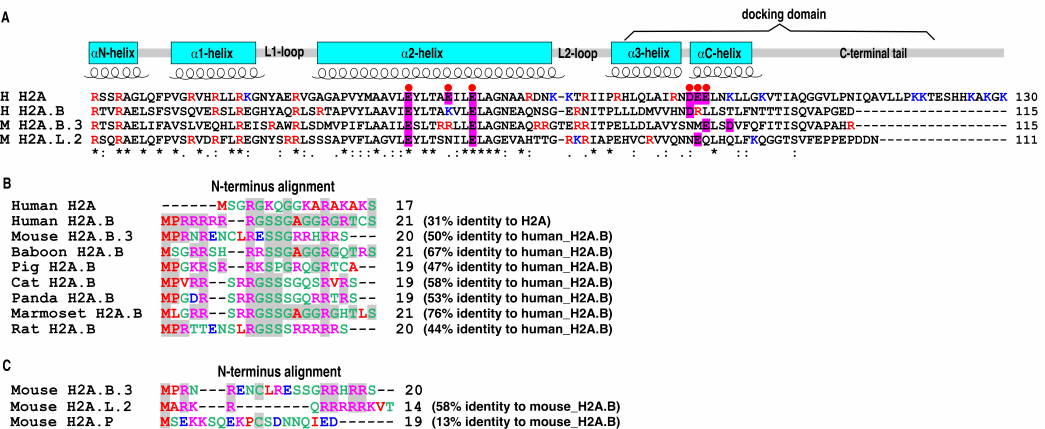
Figure 1. ( A ) Multiple protein sequence alignments of human H2A and H2A.B, and mouse H2A.B.3 and H2A.L.2. The structural features of the histone fold are annotated above the alignments. Arginine and lysine residues are highlighted in red and blue, respectively. The residues composing the “acidic patch” are shaded in magenta, and the “acidic patch” residues of H2A are annotated with red dot on top. The similarity of amino acid residues is indicated by the following symbols below the alignment: “*” (identical residues), “:” (residues with strongly similar properties) and “.” (residues with weakly similar properties). ( B ) Multiple amino acid residue alignments of the H2A.B N-termini of di ff erent eutherian mammals. Residues identical to those of human H2A.B are shaded in grey. ( C ) Alignments of the N-termini of all the short histone H2A variants expressed in the mouse. The residues identical to those of H2A.B.3 are shaded in grey. The amino acid residues are coloured following the default colour scheme of Clustal Omega (acidic residue, blue; basic residue, magenta; hydrophobic residue, red; polar residue, green). All multiple sequence alignments are generated using the EBI web server Clustal Omega (version 1.2.4) (EMBL-EBI, Hinxton, Cambridge, U.K) with default parameters. The sequence identity is calculated by Clustal